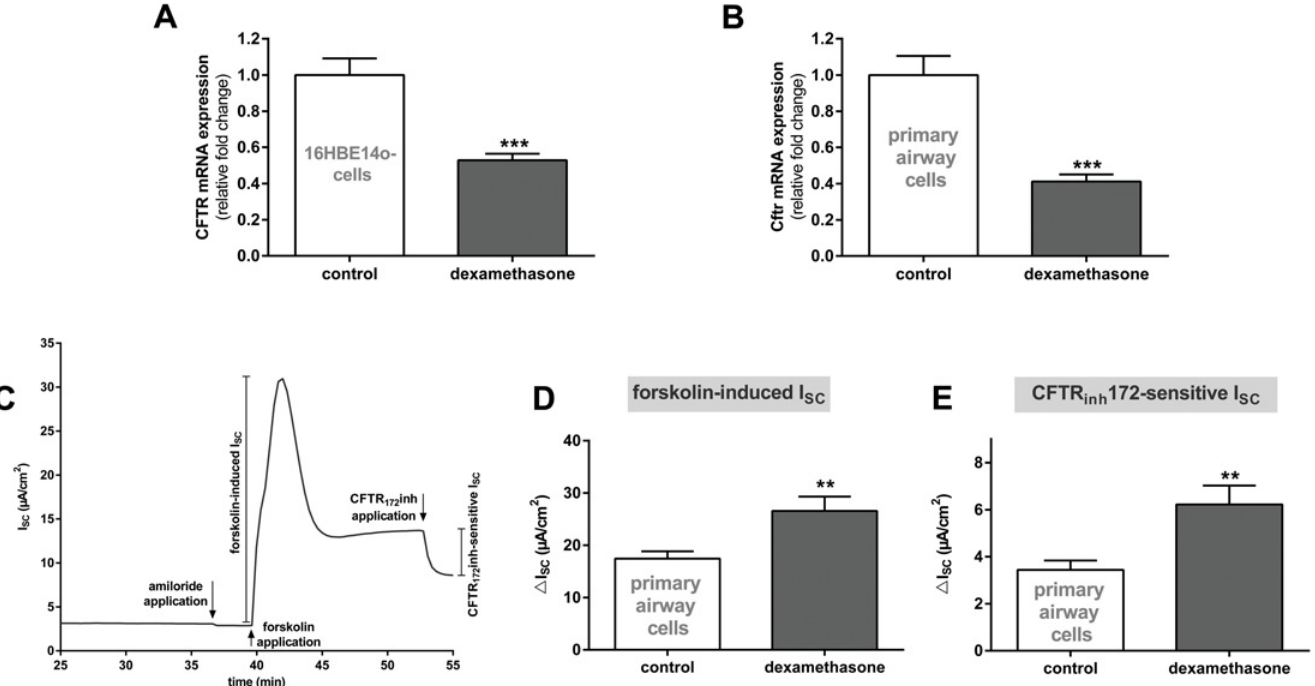
Fig 6. Dexamethasone reduces CFTR/Cftr mRNA expression and increases channel activity in airway epithelial cells. A/B: Graphs represent the mean + SEM for normalized CFTR/Cftr mRNA expression in response to 100 nM dexamethasone for 24 h acquired by RT-qPCR. A: 16HBE14o- cells (n = 8, *** p < 0.001, T-test compared to control cells without dexamethasone addition). B: Primary rat airway epithelial cells (n = 7 – 8, *** p < 0.001, T-test compared to control cells without dexamethasone addition). C: Typical current tracing of primary airway epithelial cells. D/E: Graphs represent the mean + SEM of I SC in response to 100 nM dexamethasone for 24 h measured in Ussing chambers. D: Forskolin-induced I SC (n = 20 – 23, ** p < 0.01, T-test compared to control cells without dexamethasone addition). E: CFTR 172 inh-sensitive I SC (n = 19 – 20, ** p < 0.01, T-test compared to control cells without dexamethasone